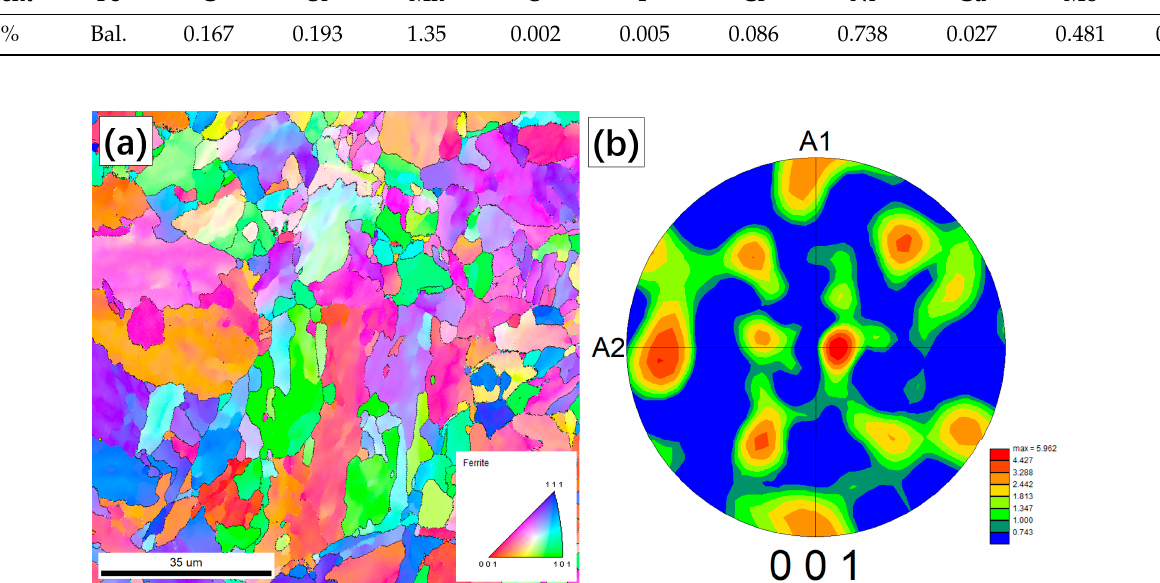
Table 1. Chemical composition of the A508-3 RPV steel.